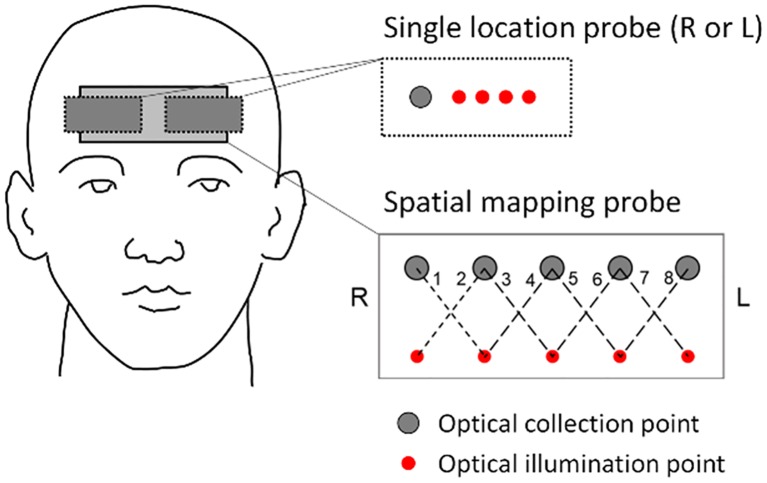
Configuration of the optical probes on the subject’s forehead.The single location probe is placed on either the right side (R: subjects 9–12) or left side (L: subjects 13–22) of the forehead, and features four source-detector separations of 2.0, 2.5, 3.0 and 3.5 cm. The spatial mapping probe (subjects 1–8) has eight single-distance channels (numbered 1–8 in the figure) at a source-detector distance of 3.5 cm, and realizes self-calibrated absolute measurements using source-detector distances of 2.5 and 3.5 cm. The optical illumination points represent the locations where light at 690 and 830 nm is delivered to tissue.